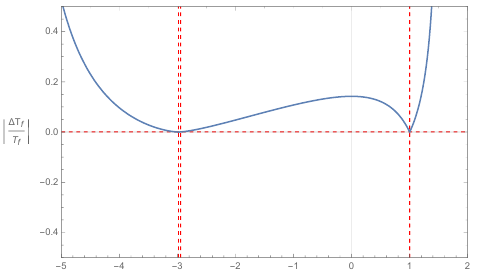
Figure 1. | ∆ T f / T f | vs. the model parameter β 2 (blue solid curve), for Model I: f = − T + (cid:112) T 2 + β 2 T G . The allowed range of β 2 , where (26) is satisfied (horizontal red dashed line), is β 1 within the vertical dashed